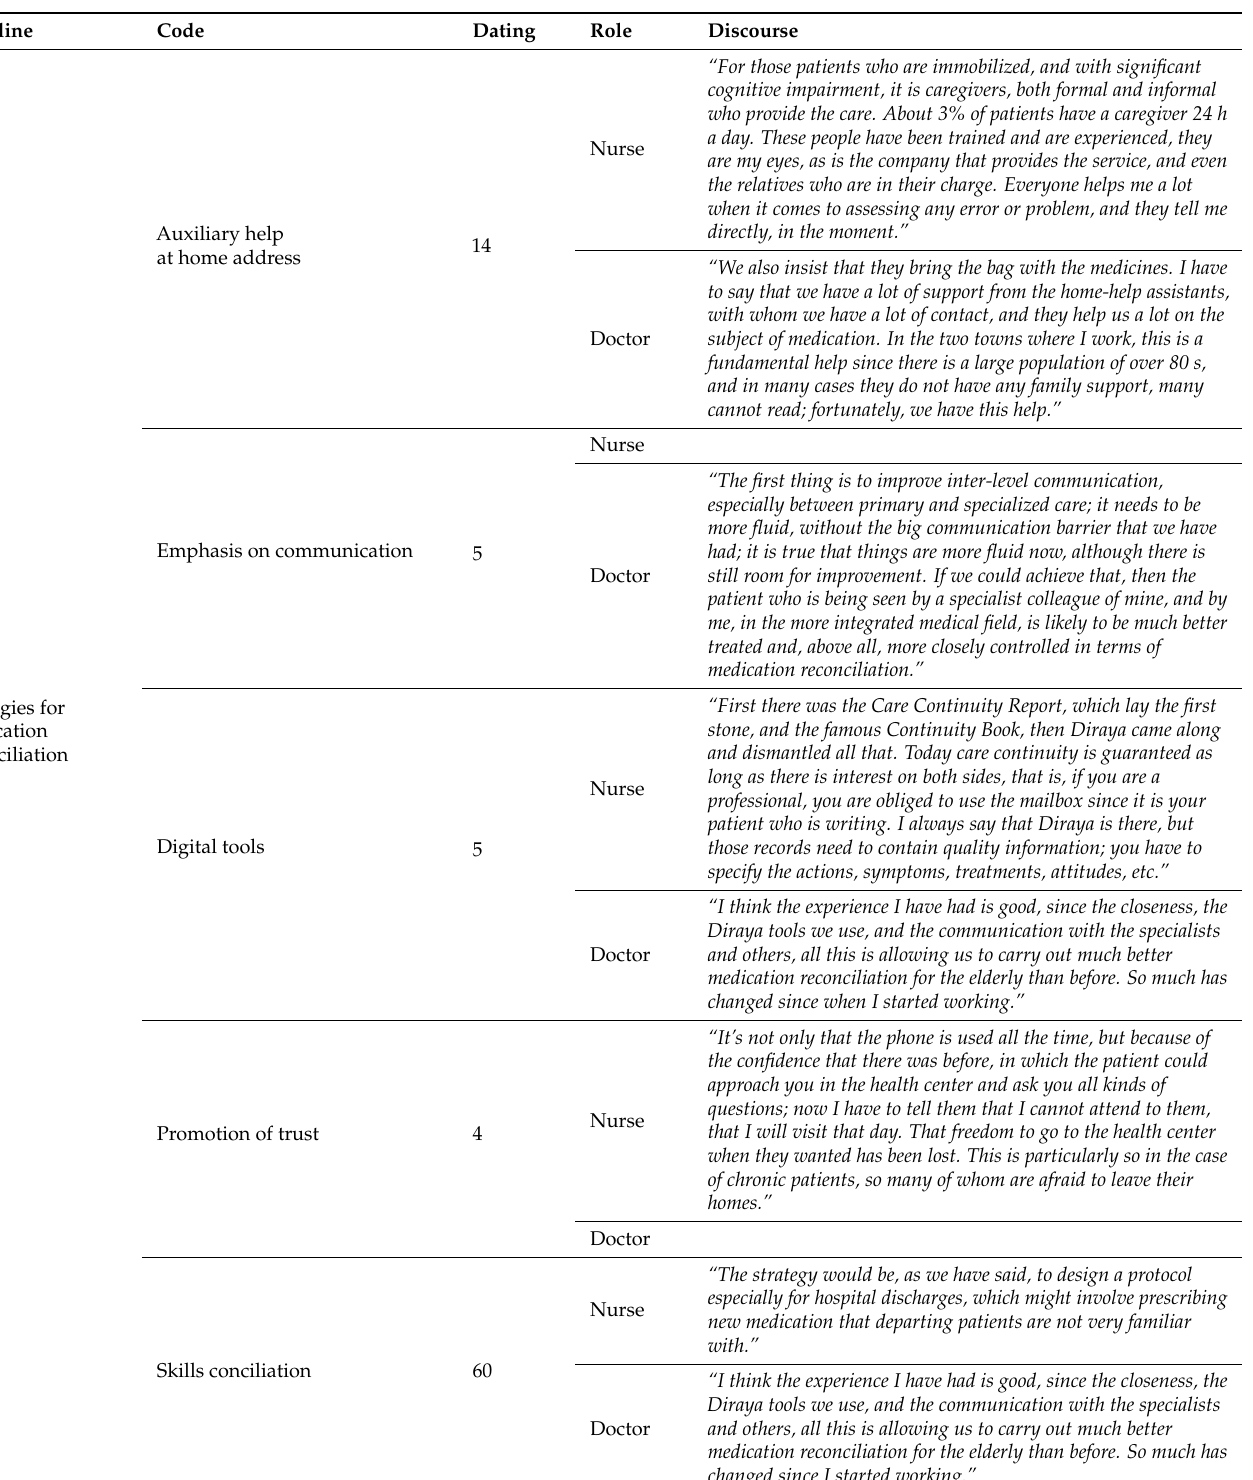
Table 5. Strategies used for drug reconciliation in the COVID-19 health crisis. Codes and discourse of nurses and primary care